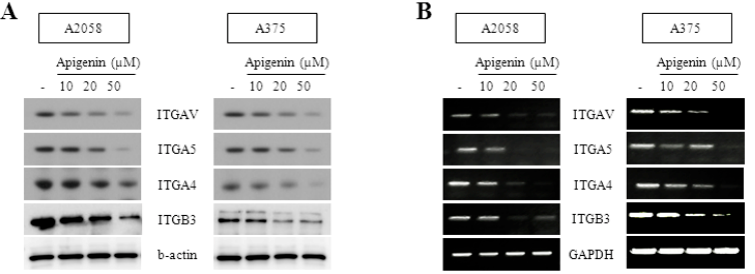
Figure 2. Inhibitory effect of apigenin on integrin protein expression. ( A ) mRNA expression of ITGAV, ITGA5, ITGA4 and ITGB3 in human melanoma A2058 and A375 cells. Cells were incubated with various concentrations of apigenin for 18 h. Cells were harvested and ITGAV, ITGA5, ITGA4 and ITGB3 mRNA levels were analyzed by RT-PCR; ( B ) Protein expression of ITGAV, ITGA5, ITGA4 and ITGB3 in Human melanoma A2058 and A375 cells. Cells were incubated with various concentrations of apigenin for 18 h. Cells were harvested and ITGAV, ITGA5, ITGA4 and ITGB3 protein levels were analyzed by western blotting. RT-PCR and western blotting were performed in triplicate and data are representative of three separate experiments.